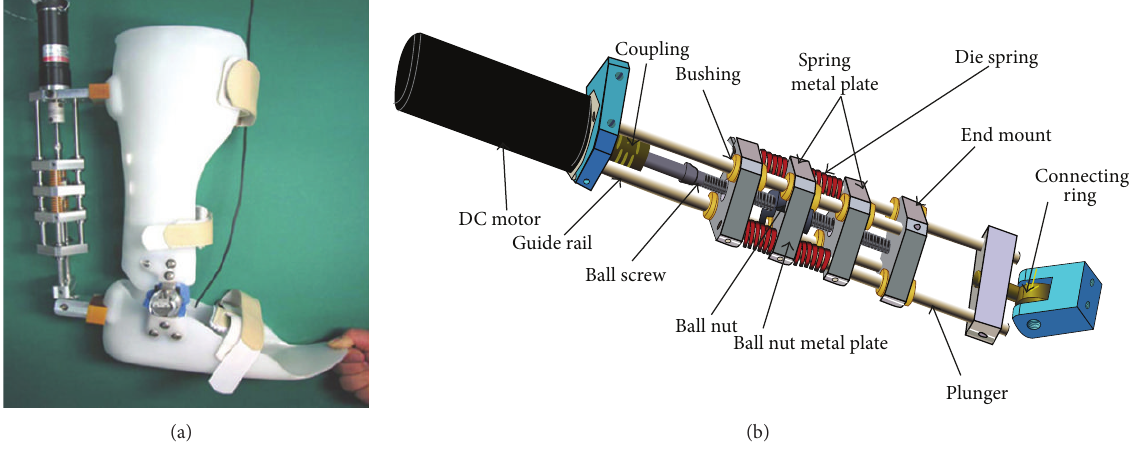
Figure 10: (a) An articulated AFO with SEA, (b) a series elastic actuator